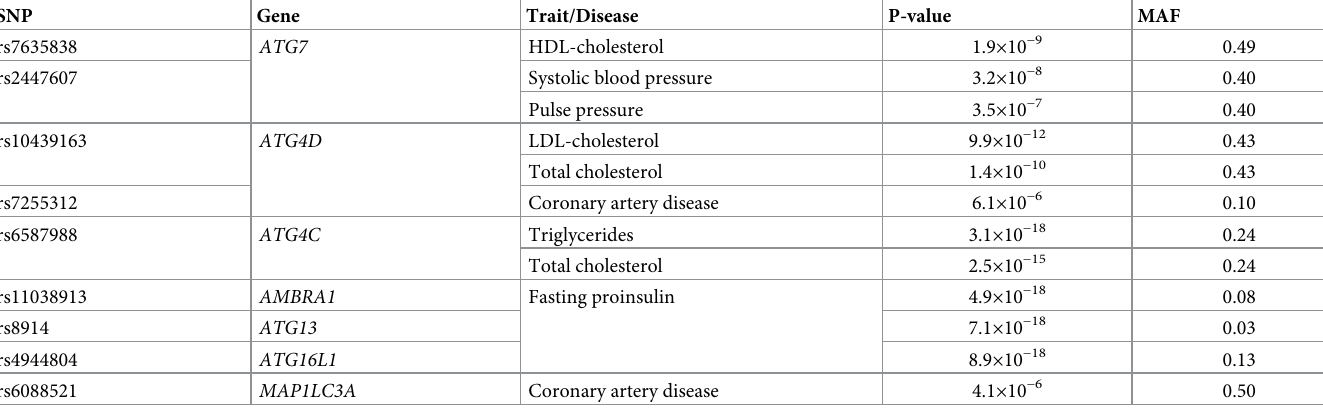
Table 3. SNPs in autophagy genes with the most significant association with cardiometabolic traits and diseases. SNP